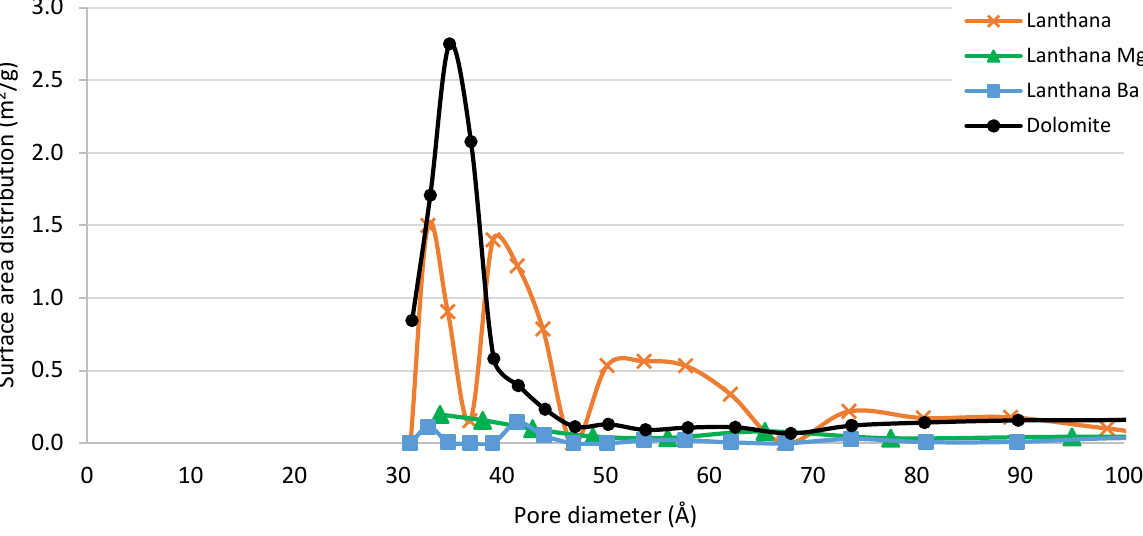
Figure 8. Comparison of the surface area distribution for dolomite, lanthana, lanthana Mg and lanthana Ba. Obtained from the N 2 adsorption–desorption isotherm data. (BJH method desorption surface area).